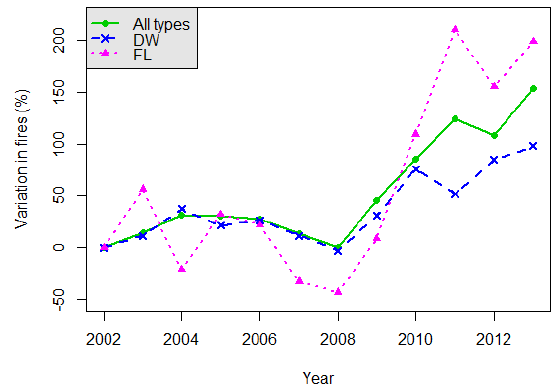
Figure 5. Annual variations of fire incidents The temporal variations of both DW and FL fires across